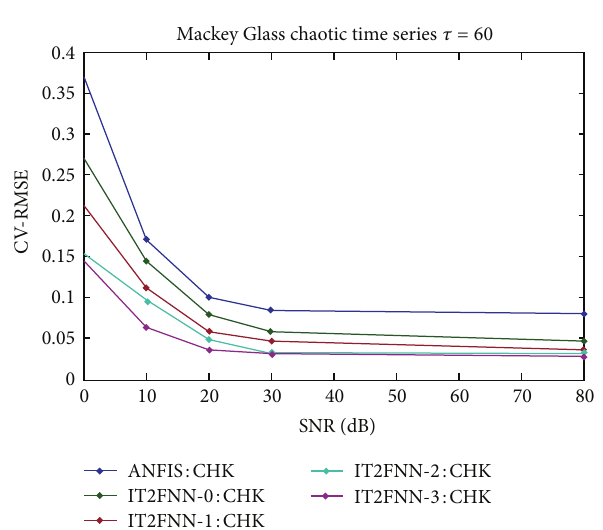
Figure 10: RMSE (CHK) values determined by ANFIS and IT2FNN models with 10-fold cross-validation for Mackey-Glass chaotic time series prediction with 𝜏 = 60